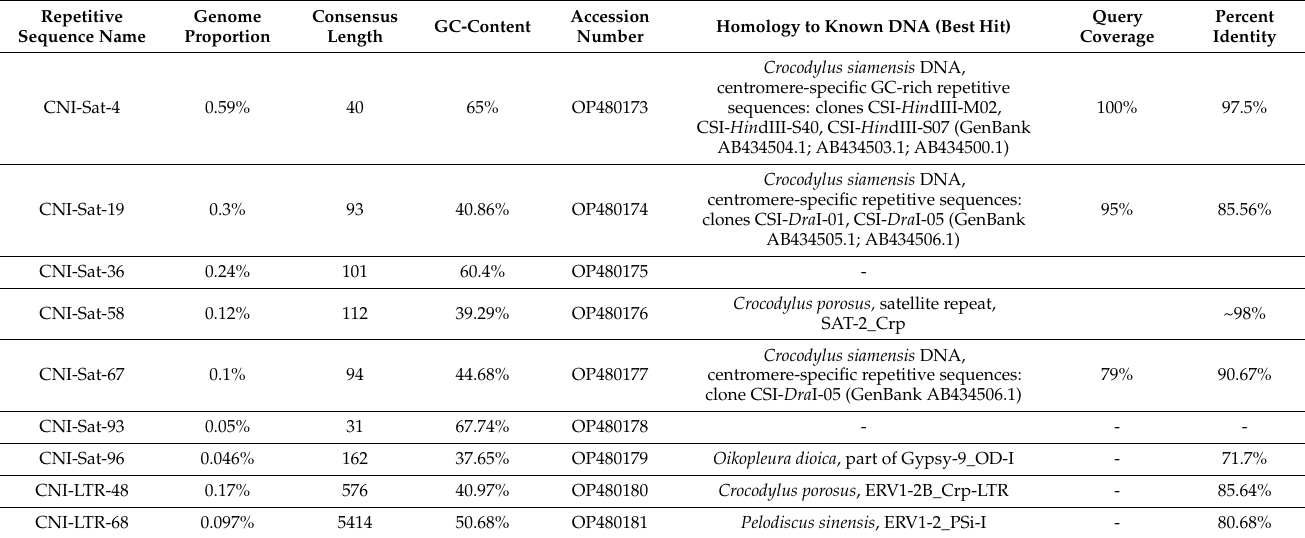
Table 1. Putative satellites (Sat) and putative LTR elements (LTR) revealed in the Crocodylus niloticus genome.